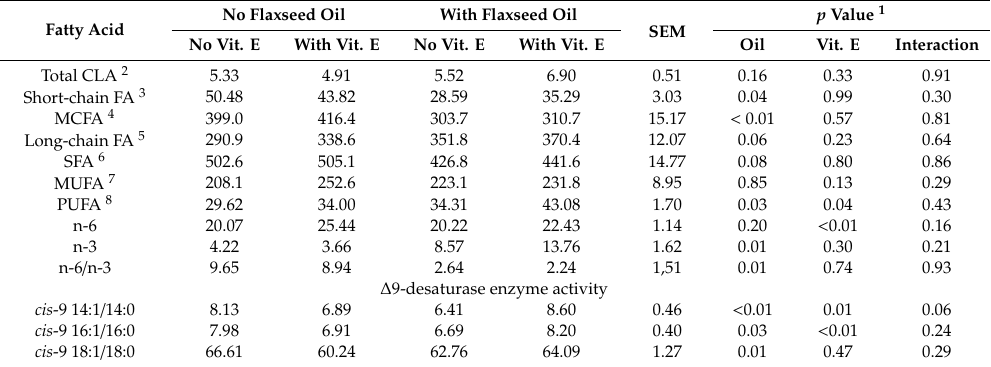
Table 5. Concentration of total CLA, short, medium, and long-chain fatty acids, n-6, n-3 (mg / g total lipids), n-6 / n-3 ratio, index of atherogenicity (IA), and thrombogenicity (IT) in milk from lactating bu ff aloes fed diet containing flaxseed oil and / or vitamin